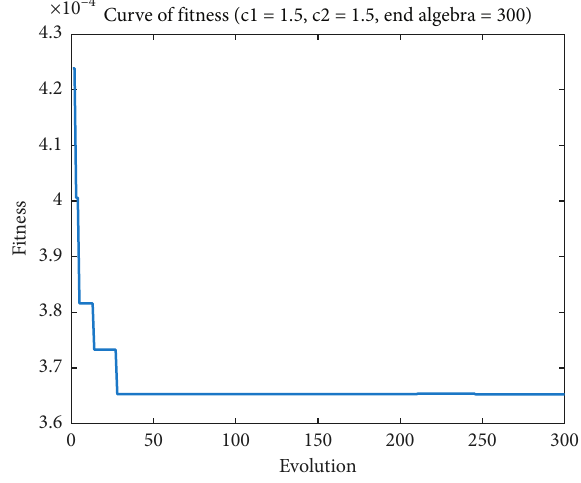
Figure 4: Fitness curve of PSO optimization.